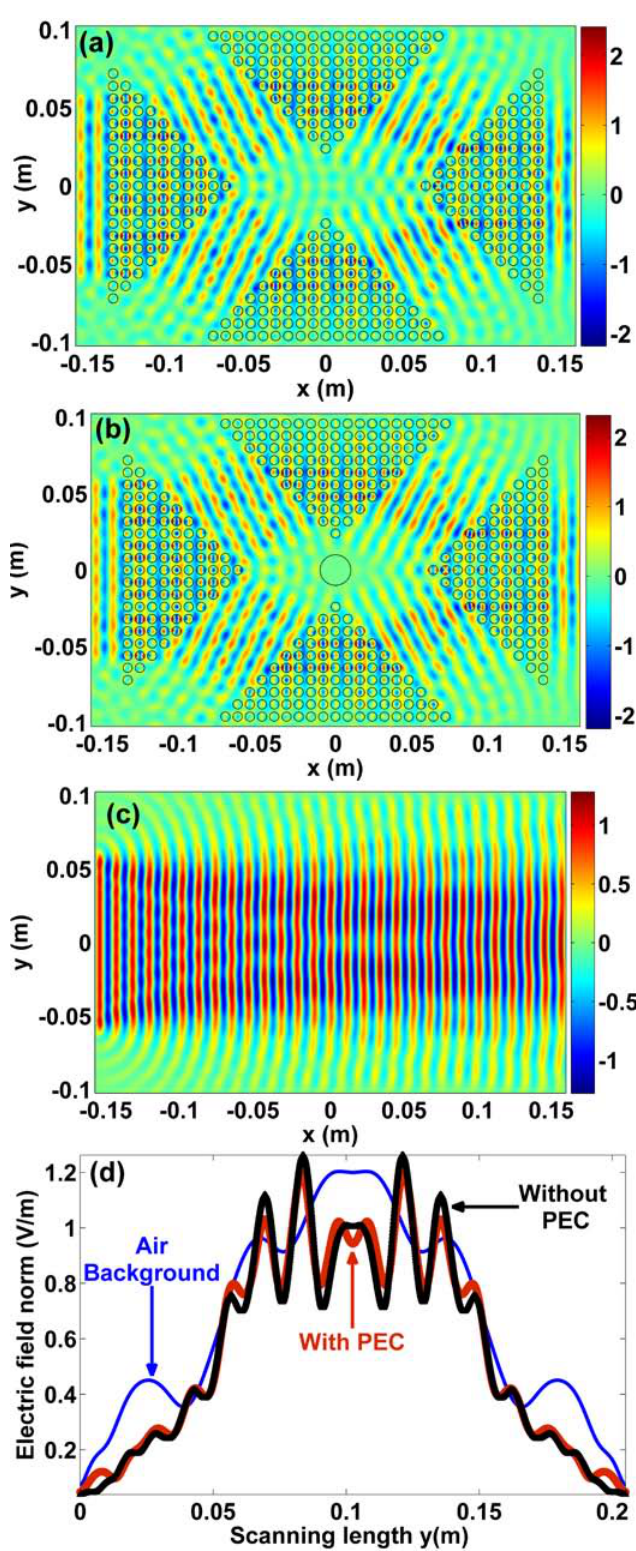
Figure 4 E z field maps at 26.77 GHz for (a) empty (b) PEC loaded PC geometry a nd ( c) a ir background r espectively. (d) S canned el ectric f ield profiles al ong the y direction a t the detecting plane at 0 157m = . x